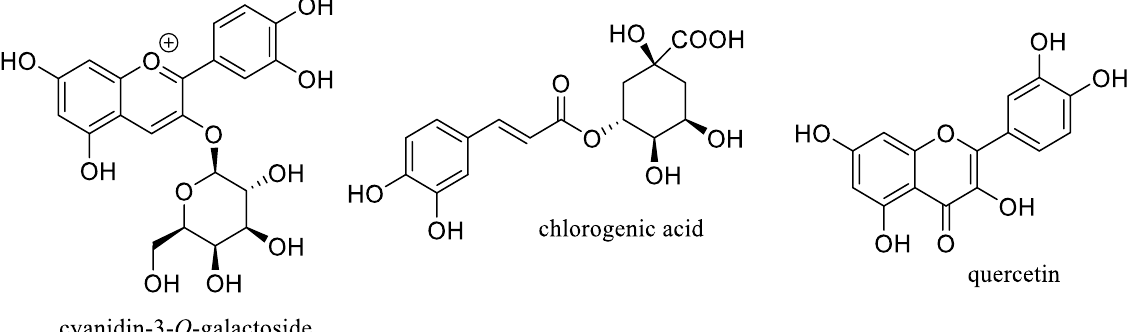
Figure 1. Structures of selected major phenolic compounds isolated from Aronia berries.